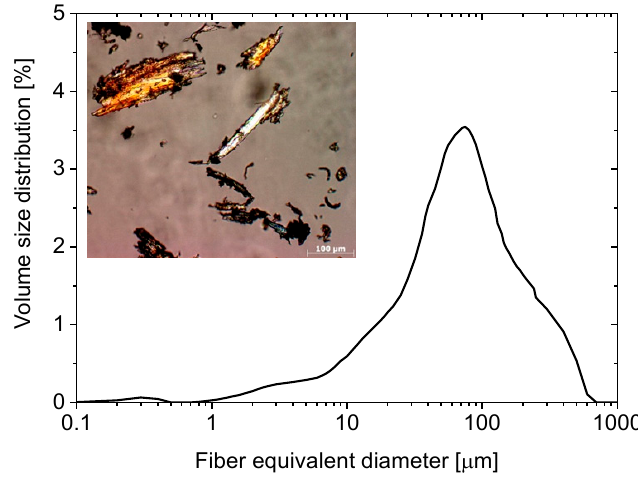
Figure 2. The volume size distribution of wood fibers.